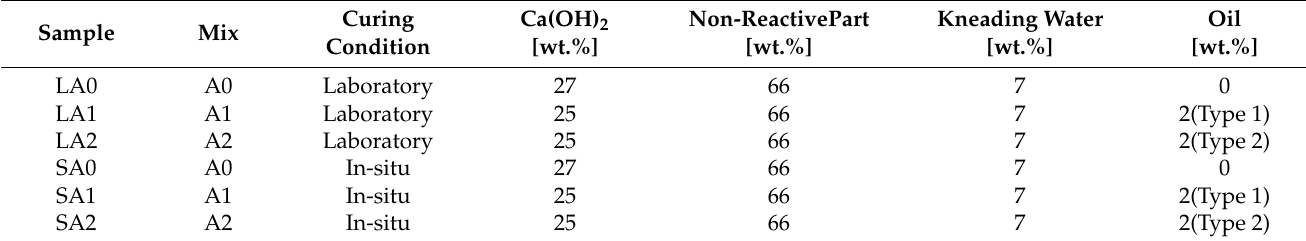
Table 3. Mix-design of the investigated